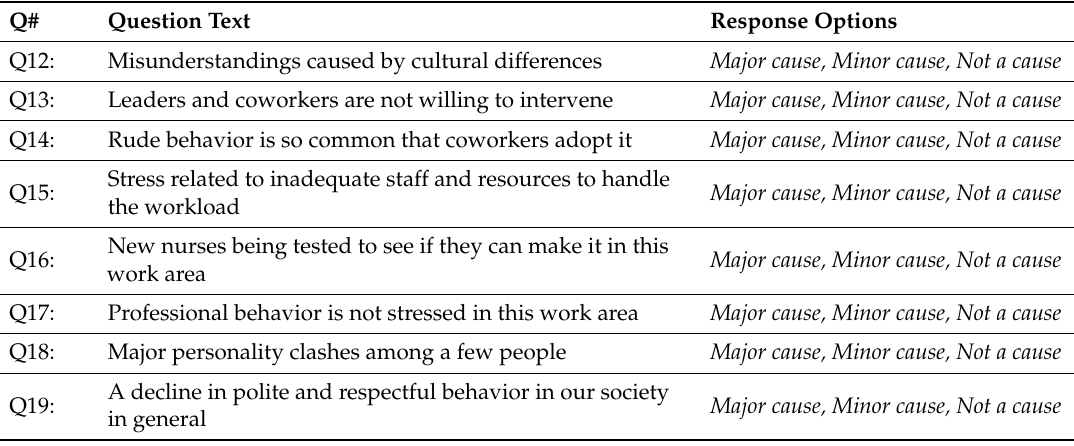
Table 3. Items that asked about the causes of lateral violence in